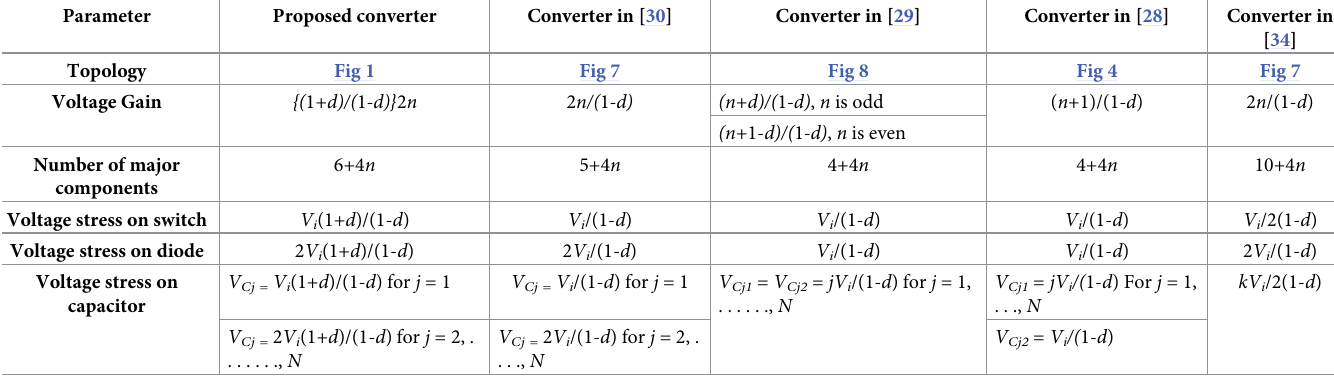
Table 1. Comparison of different parameters of the developed dc-dc cascaded converter with others.